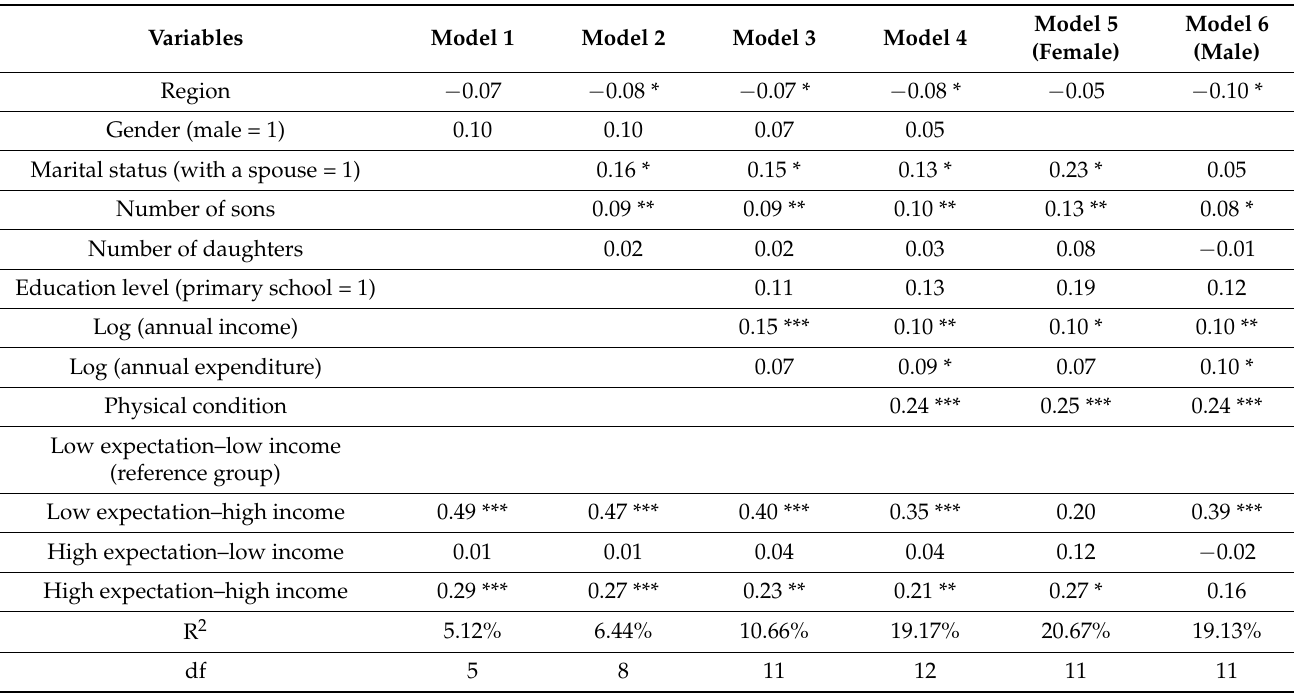
Table 6. Relationship between different types of differences in filial piety and life